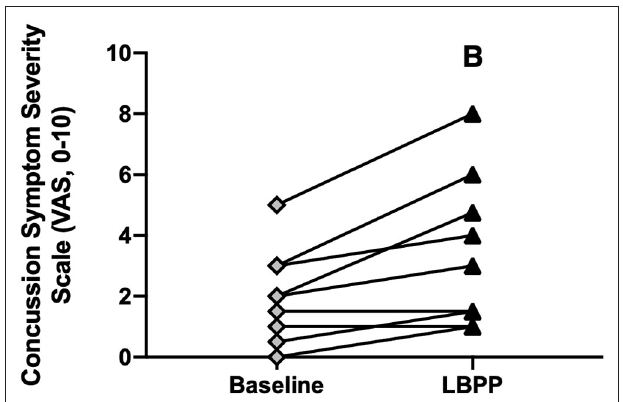
FIGURE 9 | Concussion symptom severity rating (Visual Analog Scale, 0–10) at baseline and after LBPP for Concussed Athletes. Values are mean ± SD. B, different from baseline ( P ≤